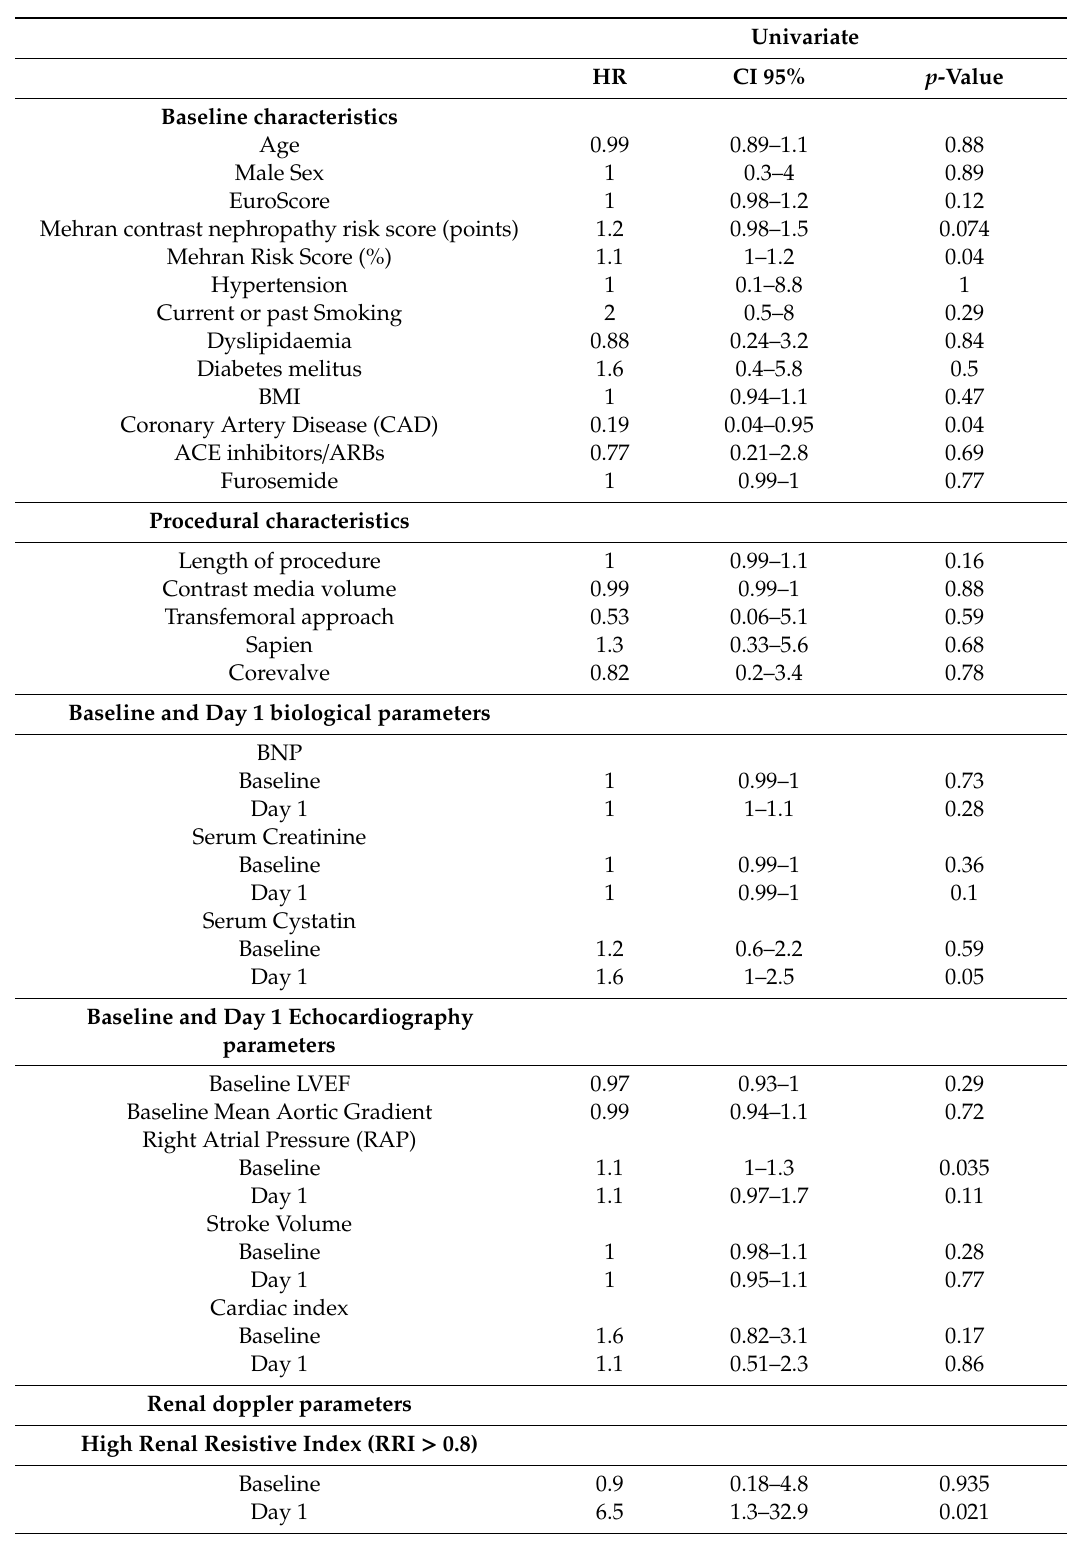
Table 8. Univariate COX regression for the development of AKI assessed by serum cystatine up to 3 days after